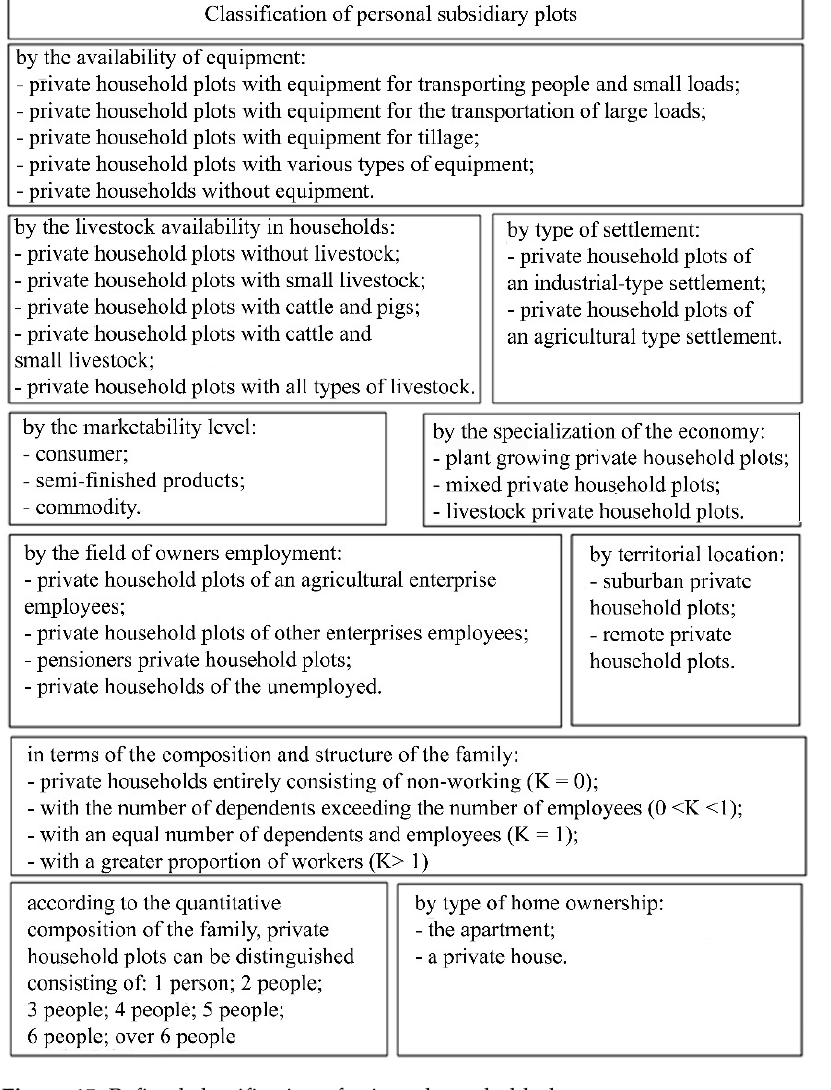
Figure 15. Refined classification of private household